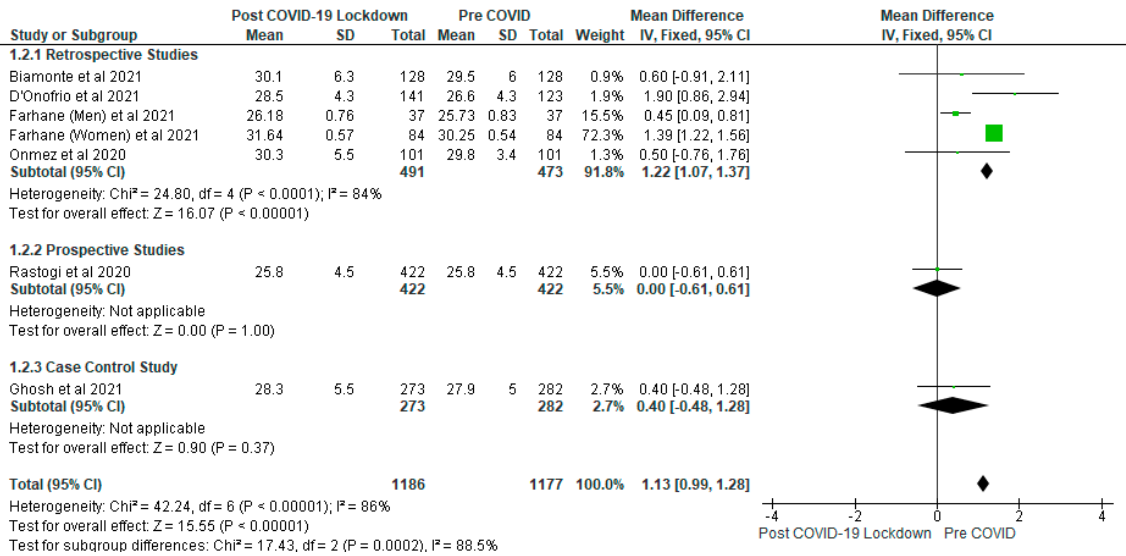
Figure 10. The effect of COVID-19 lockdown on Body Mass Index (kg/m 2 ).